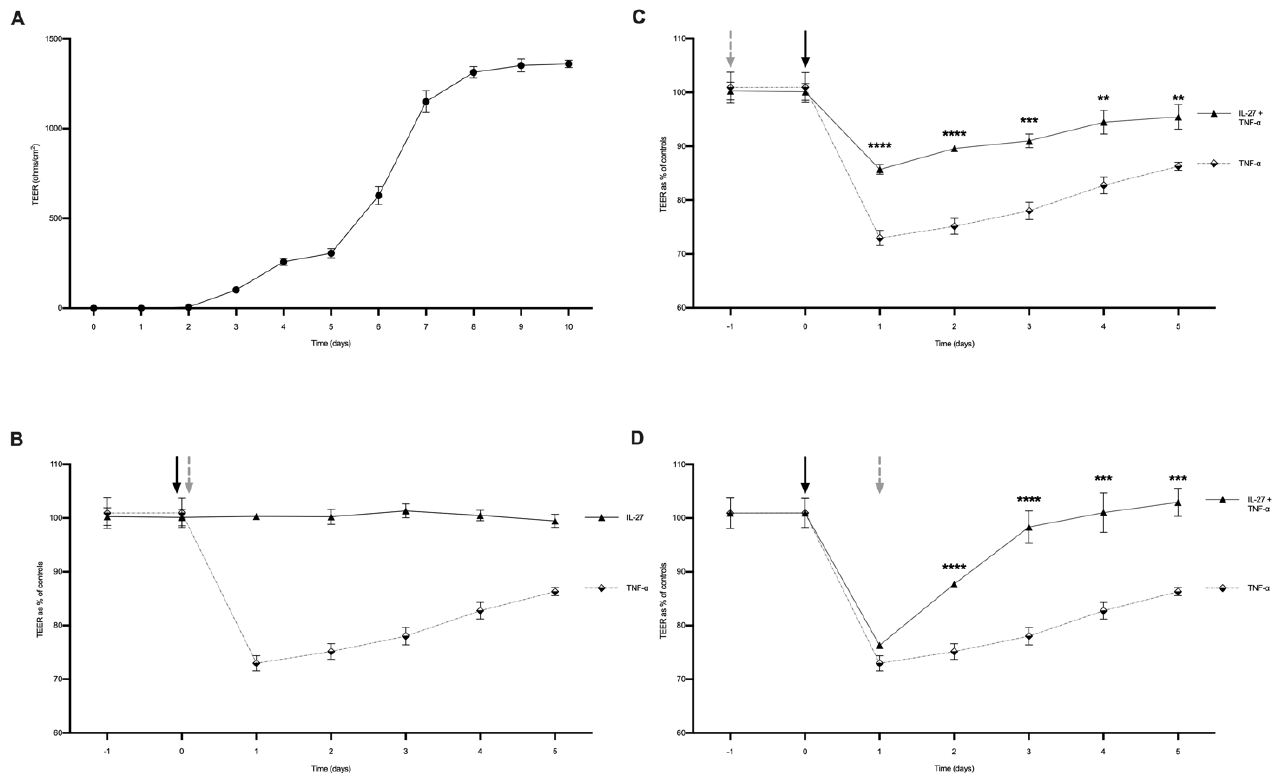
Figure 1. IL-27 effect on paracellular permeability of human organoid-derived monolayers. Paracellular permeability measured by trans-epithelial electrical resistance. ( A ) Human organoid-derived monolayers reached confluence 8 days post-seeding with stable TEERs. ( B ) Stimulation of monolayers with TNF- α (100 ng/mL administered day 0, black arrow) increased paracellular permeability by ≈ 25% that of unstimulated controls, whereas rhIL-27 (grey arrow) alone did not influence permeability. ( C ) Pre-treatment of monolayers with rhIL-27 (100 ng/mL) 24 h prior (grey arrow) to administration of TNF- α (black arrow) reduced the increase in permeability seen with TNF- α alone. ( D ) Post-treatment of monolayers with rhIL-27 (100 ng/mL) (grey arrow) 24 h after TNF- α administration (arrow) resulted in rapid recovery of paracellular permeability compared to monolayers treated with TNF- α alone. n = 3 individual patient-derived organoids with 3 technical replicates/experiment with three TEER measurements were taken for each sample at each timepoint, presented as mean ± SD. Statistical analysis with one-way ANOVA with Bonferroni correction. * p < 0.05, ** p < 0.01, *** p < 0.001 and **** p < 0.0001; ns = not significant.